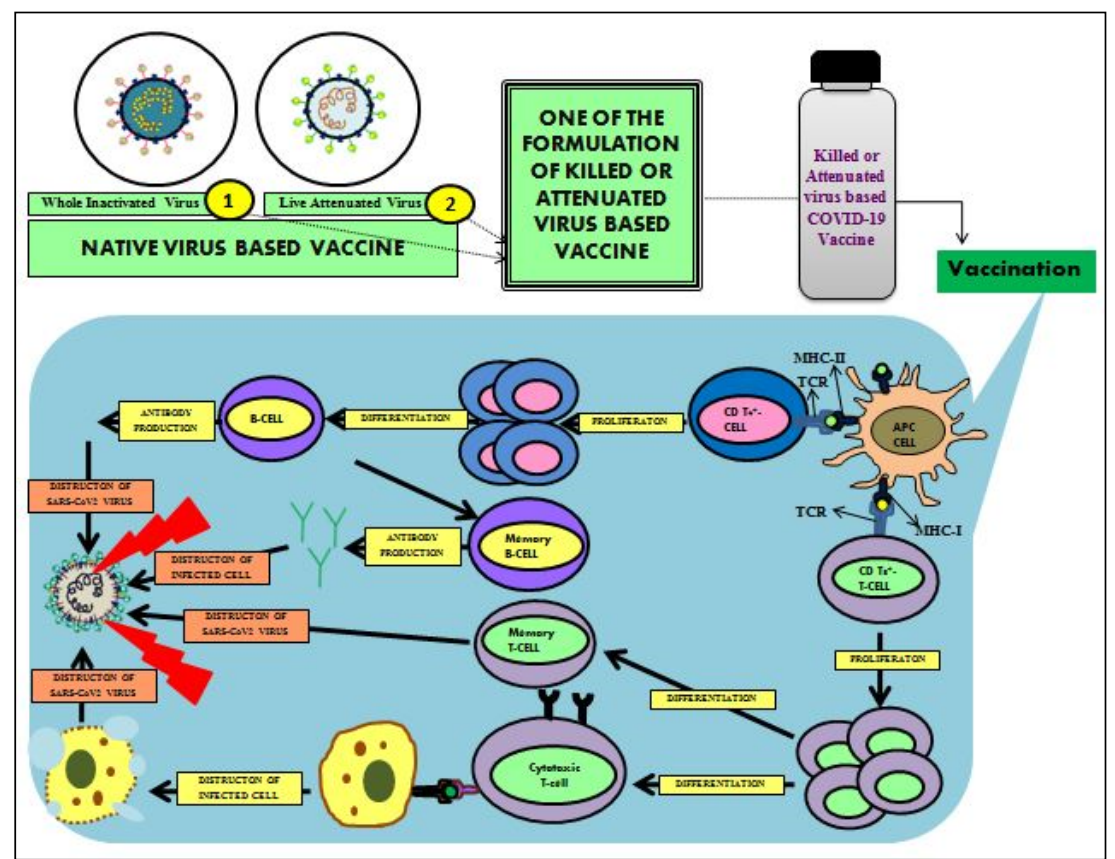
Figure 13. Mechanism of whole virus-based vaccine for inducing immunity against COVID-19: ( 1 )